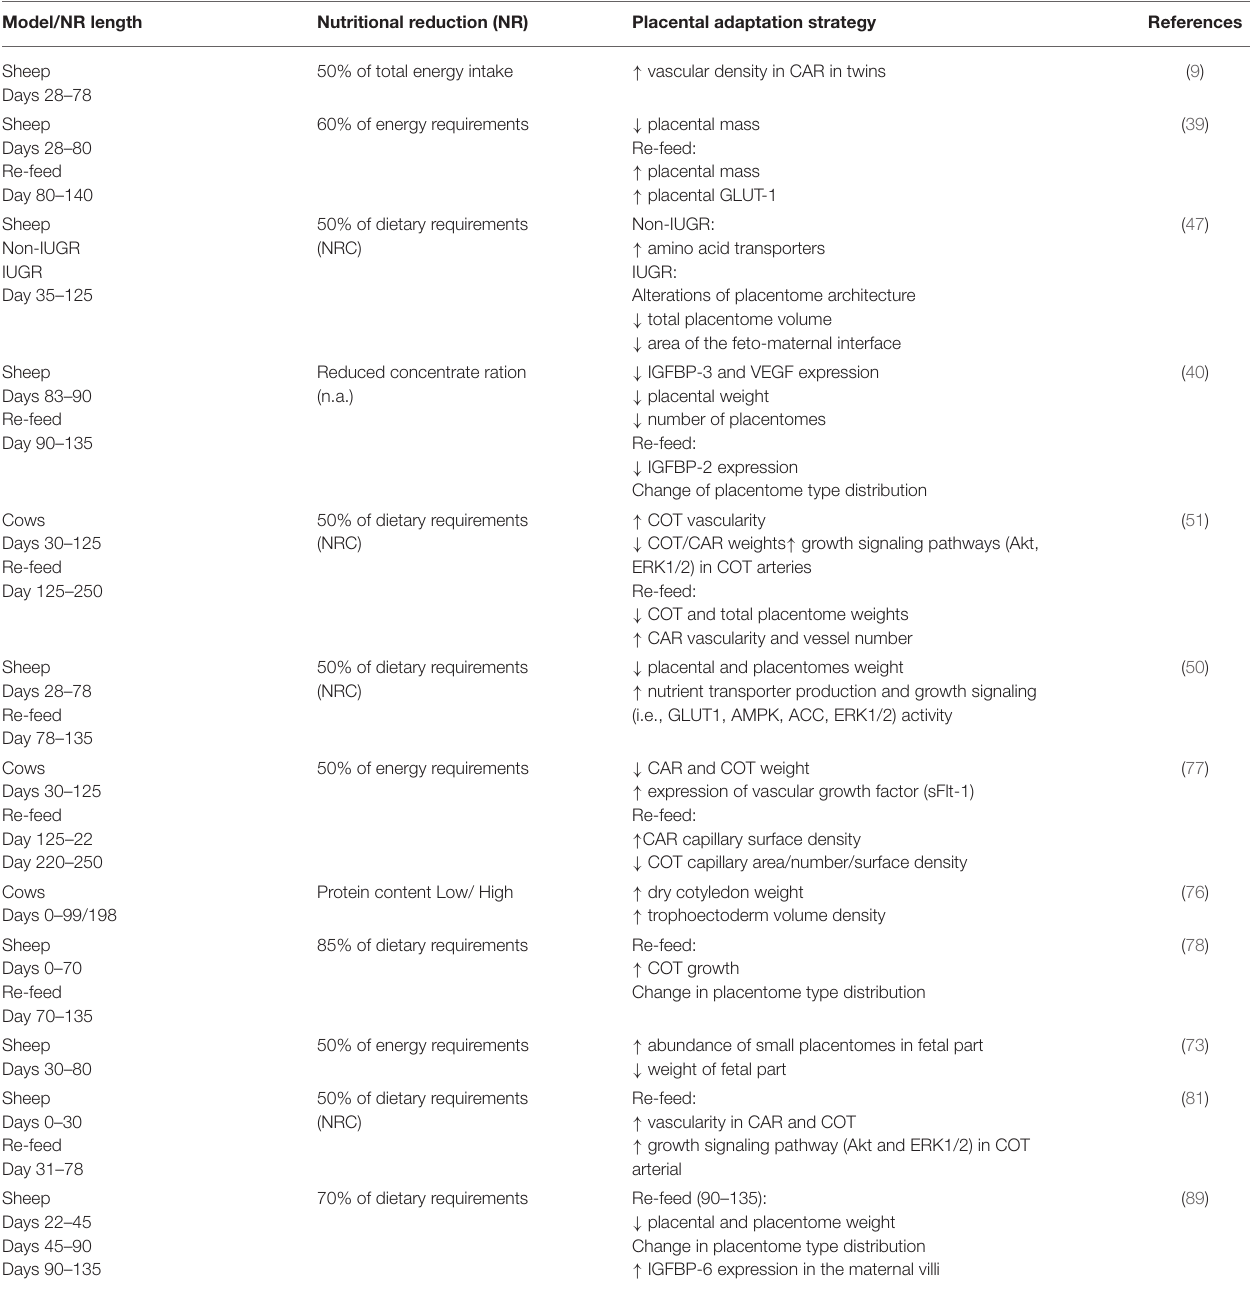
TABLE 2 | Relevant strategies of placental adaptations in ruminants following maternal undernutrition during early to